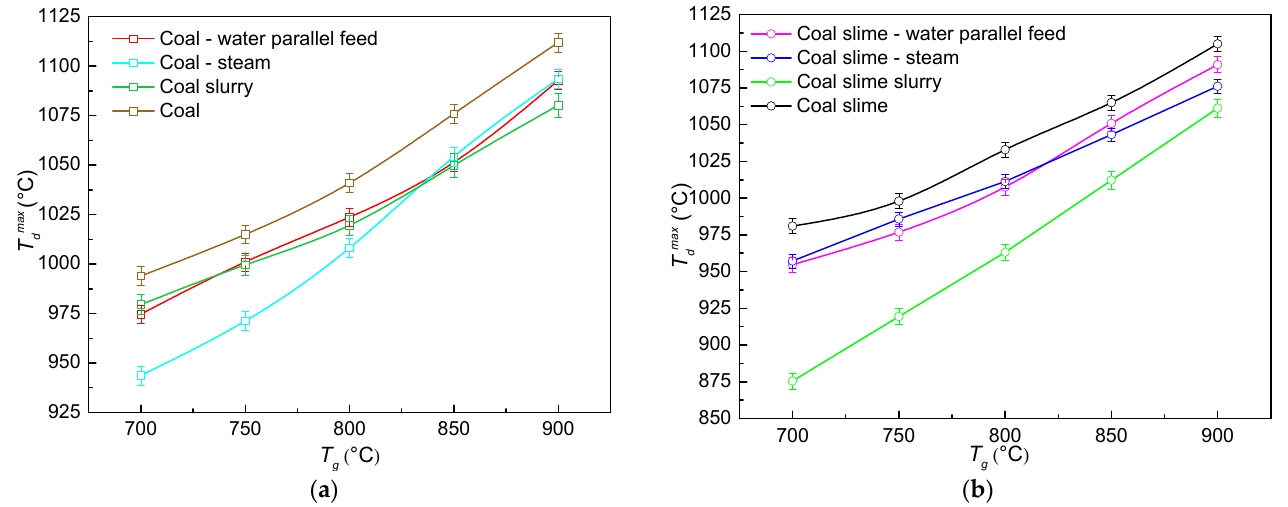
Figure 7. Maximum combustion temperatures of fuels based on bituminous coal ( a ) and coal slime ( b ) when varying the method of introducing the components and initial temperature in the combustion chamber.